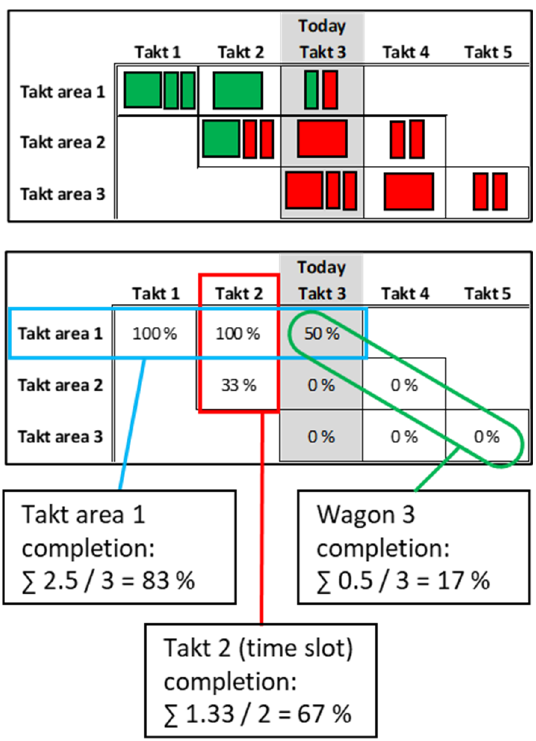
Figure 8. The realization of the takt schedule can be examined by takt (vertically), by takt area (horizontally) and by wagons (diagonally). The green work steps in the work packages have been completed acceptably. The red work steps have not yet been completed.